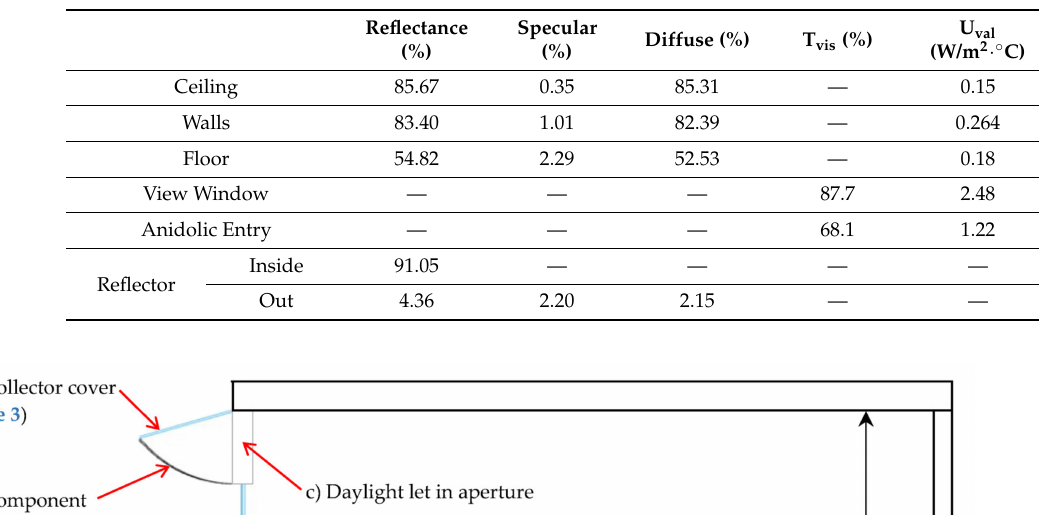
Table 3. Optical properties of the space and ADS elements.